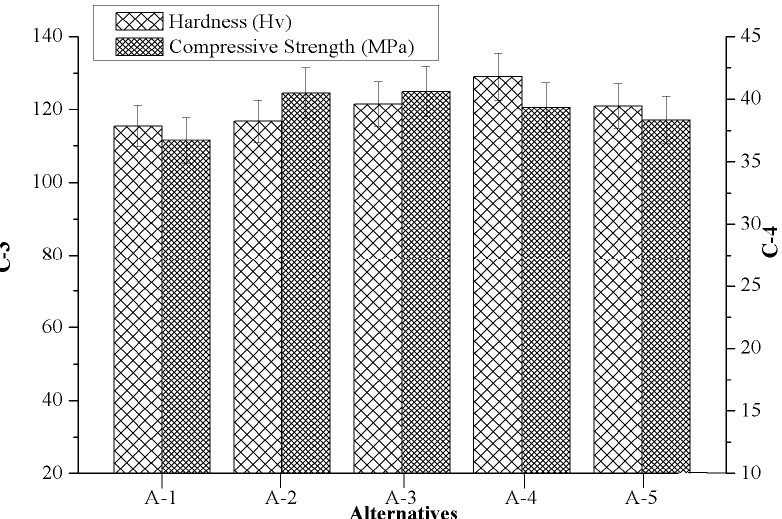
Figure 4. Variation of criterion-3 together with criterion-4 in respect to the values of alternatives .